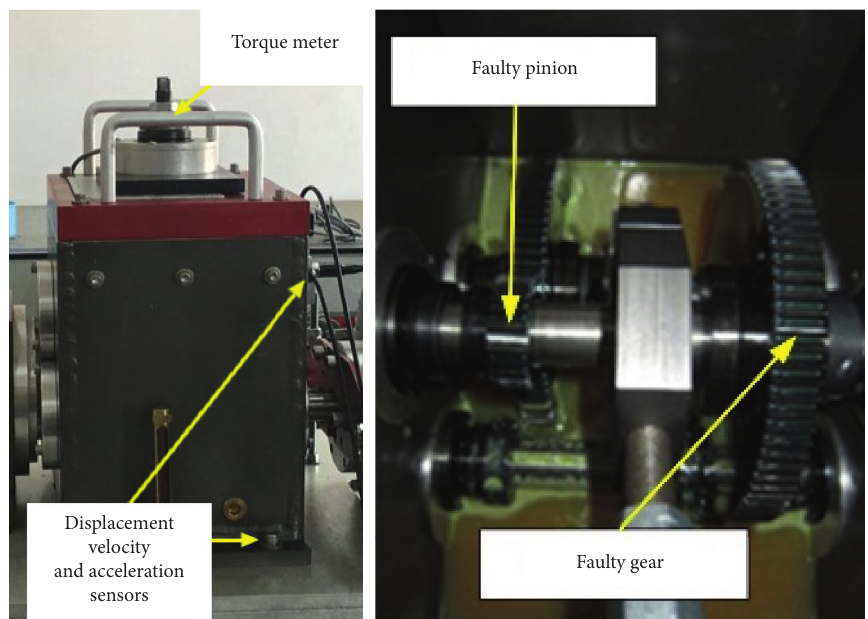
Figure 7: The position of sensors and internal structure of